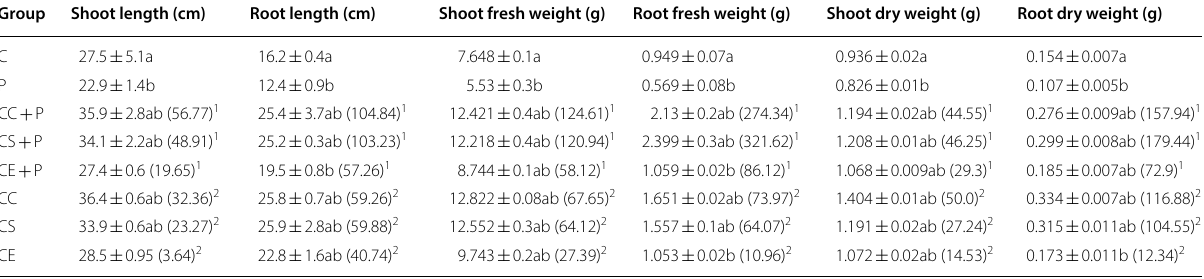
All data are presented as mean SD (n 3). The same letters with in a column are significantly different (Tukey’s Test p ± = between the control and treated plants; “b” indicates the statistical difference between the pathogen infested and treated plants C control, P pathogen, CC P culture cells and pathogen, CS P culture supernatant and pathogen, CE + + supernatant, CE culture